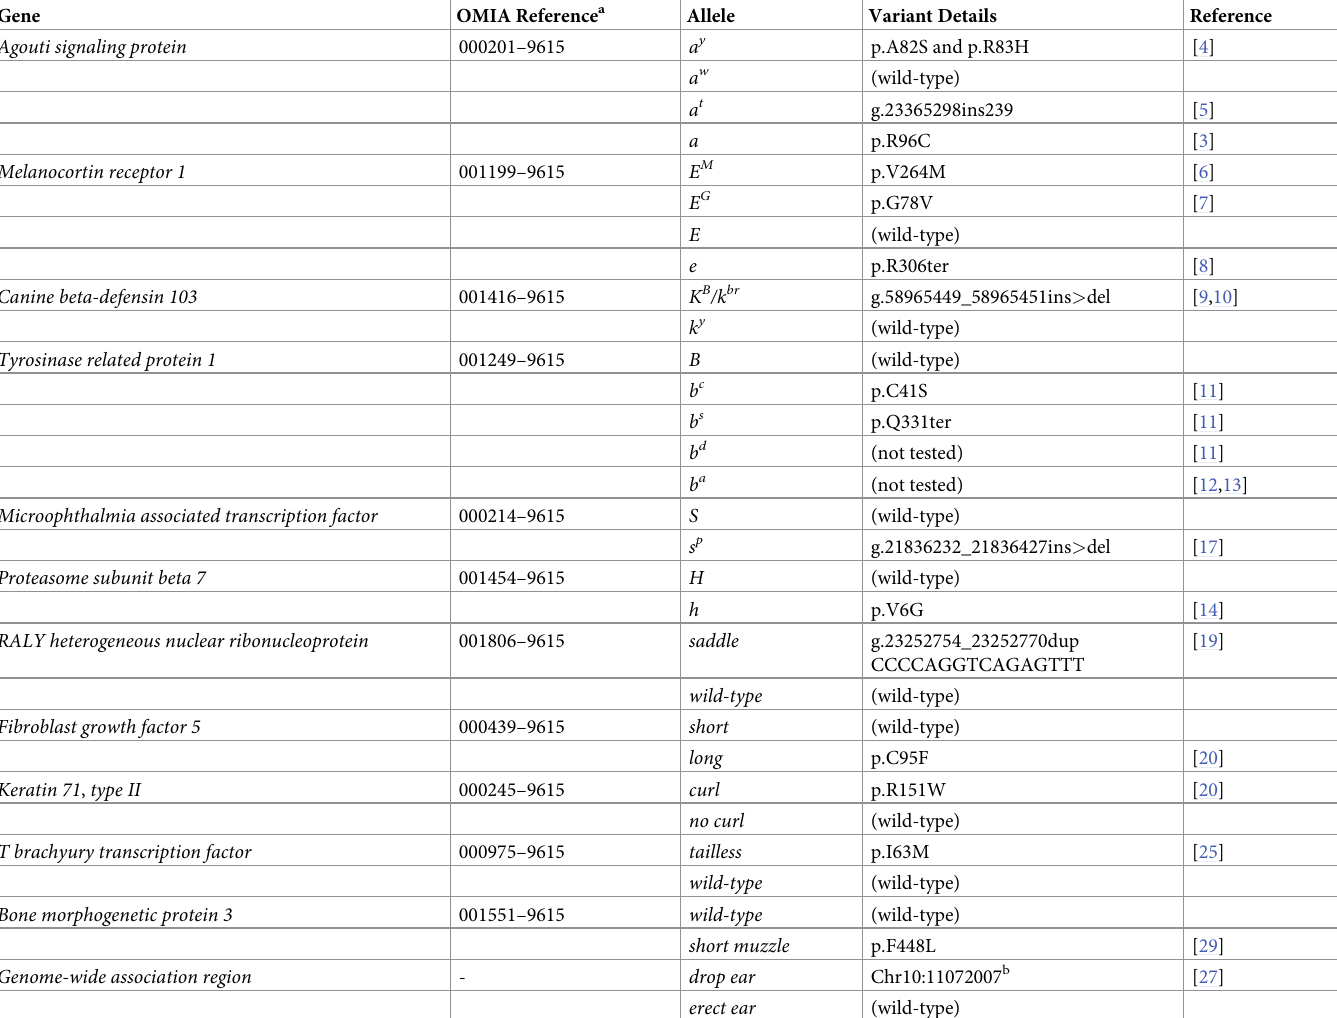
Table 1. Genes and markers genotyped for breed